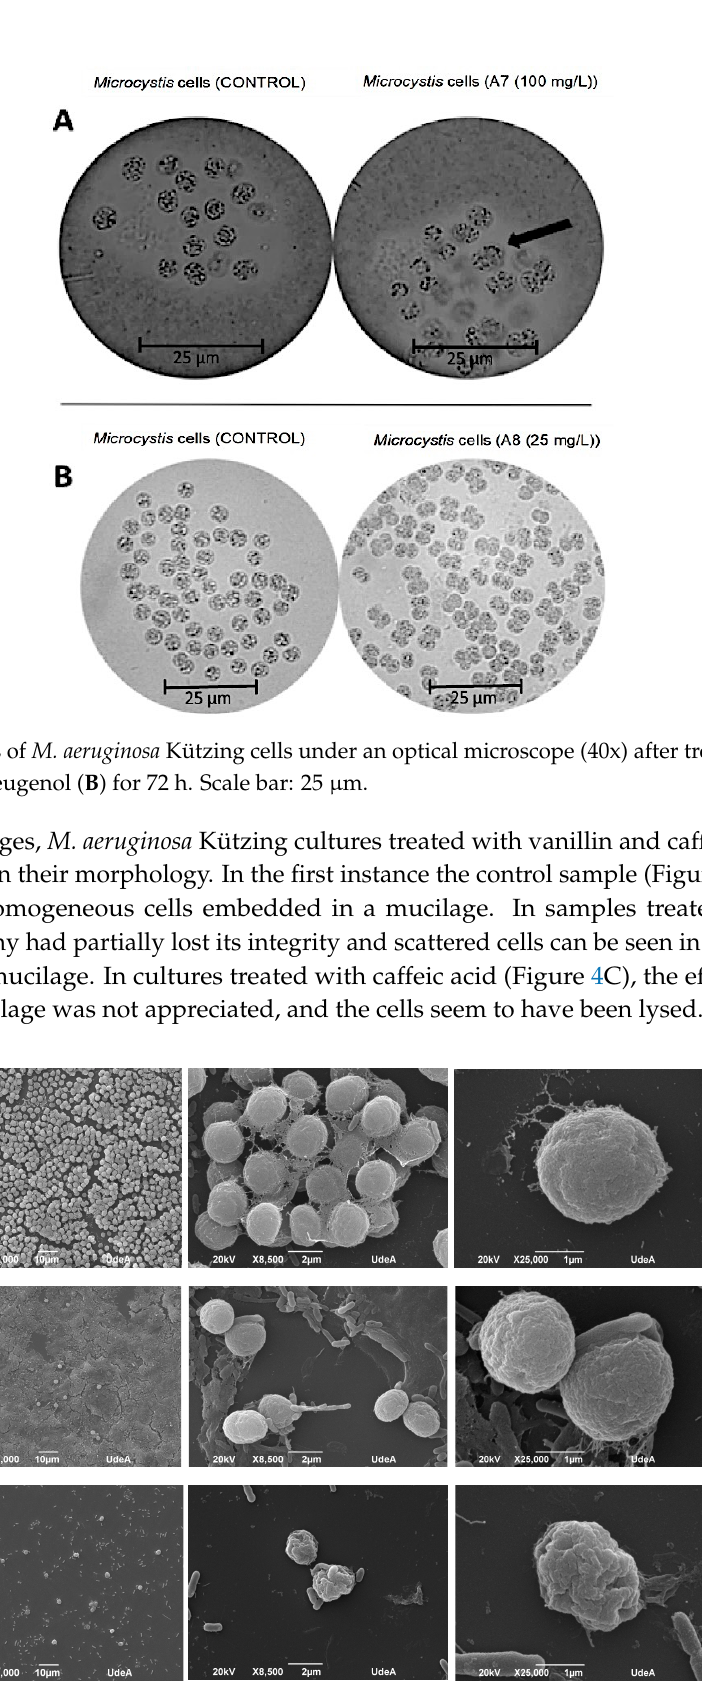
Figure 4. Scanning Electron Microscope (SEM) images showing M. aeruginosa Kützing colonies without treatment ( A ) and exposed to vanillin ( B ) and caffeic acid ( C ).